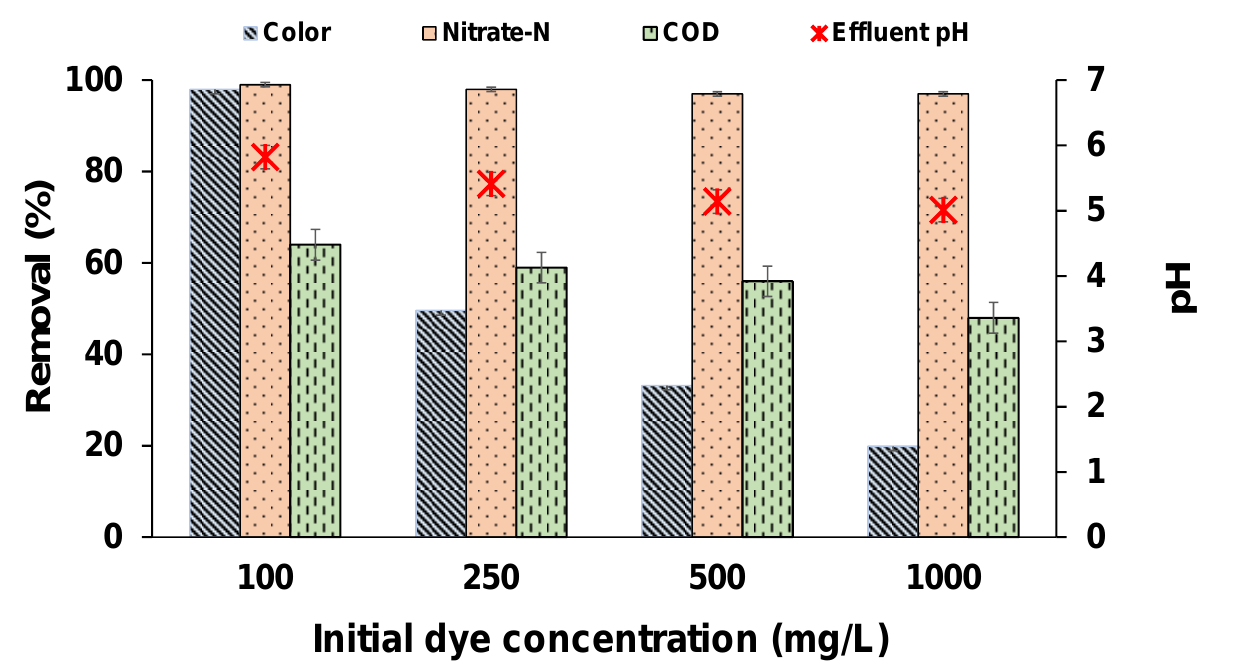
Figure 1. Effect of dye concentration on MO decolourization after 12 h (temperature: 30 ± 2 °C; volume: 150 mL; MLSS: 1 g/L; RPM: 110 ± 2; time: 12 h).